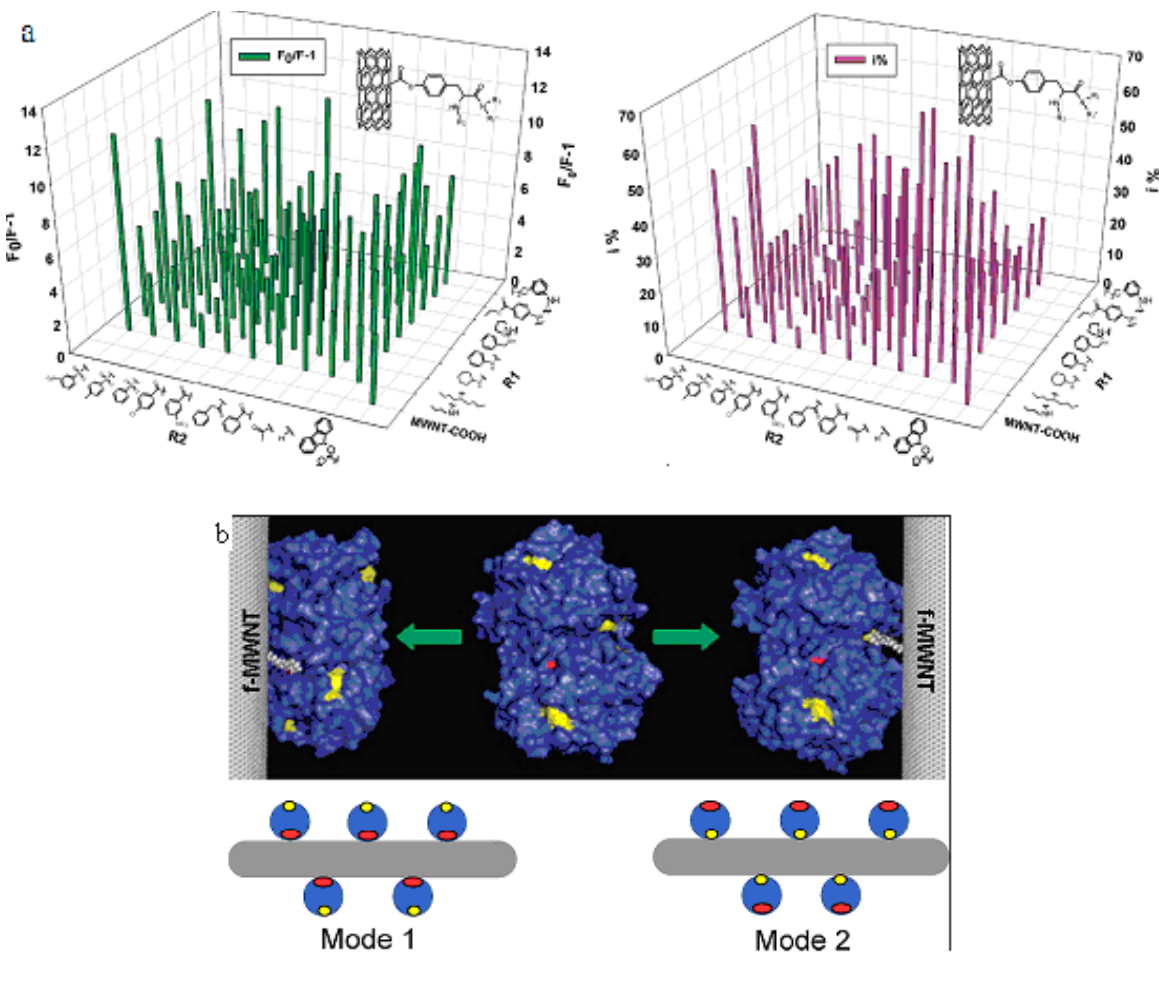
Figure 7. (a) The quenching of ChT’s fluorescence (left) and inhibition of its enzymatic activity (right) by f-MWNTs. (b) Models showing different ways f-MWNTs bind to ChT (reproduced with permission from [38] © 2004, American Chemical